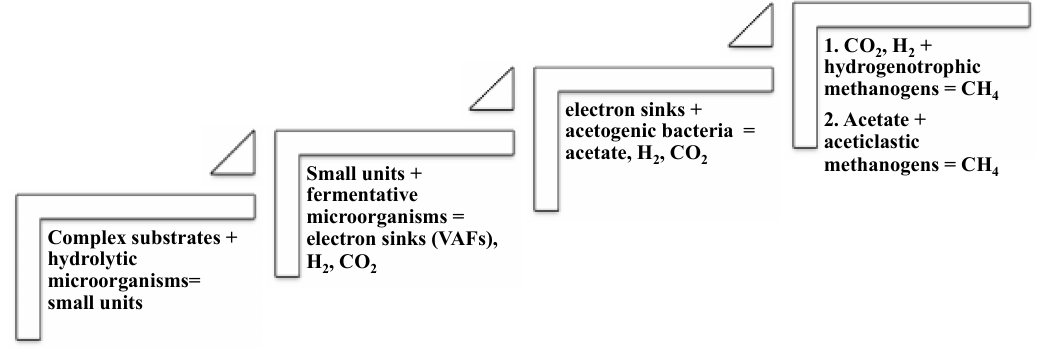
Figure 1. An overview of microbial processes involved in anaerobic digestion. 77